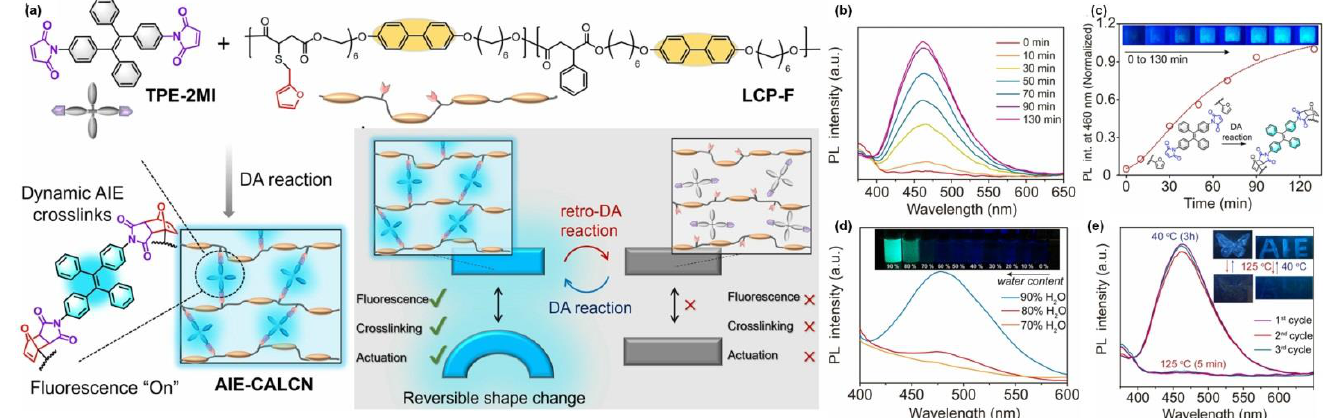
Figure 4. ( a ) The chemical structures and dynamic mechanism of the prepared AIE-CALCNs via the reversible of DA reaction. ( b ) PL spectra of TPE-2MI/LCP-F film keeping at 40 °C for different durations. ( c ) Plot of fluorescence intensity versus different times at 40 °C, and photographs of the sample taken under UV light. ( d ) PL spectra and photographs of AIE properties of TPE-2MI-furan reactants. ( e ) PL spectra and photographs of AIE-CALCN over multiple cycles of switching taken under UV light. Reprinted with permission from Ref. [42]. 2022, Wiley-VCH.